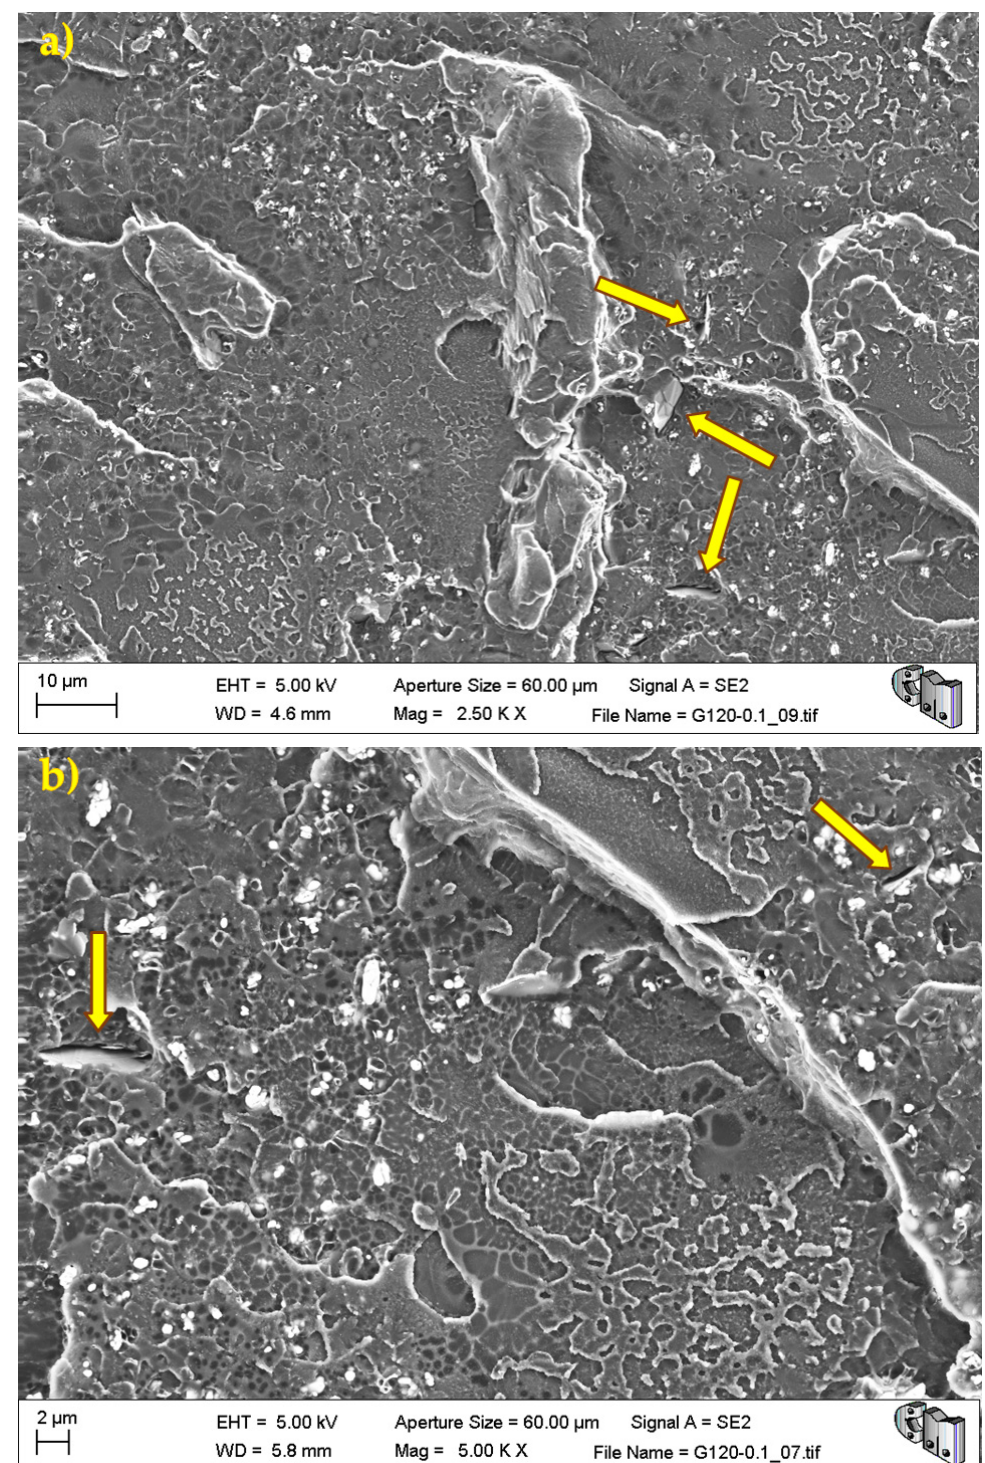
Figure 5. G120-0.1 fracture surface. The arrows indicate voids and flaws between the bone cement and the HRGO due to poor adhesion between both: ( a ) lower magnification, and ( b ) higher magnification.